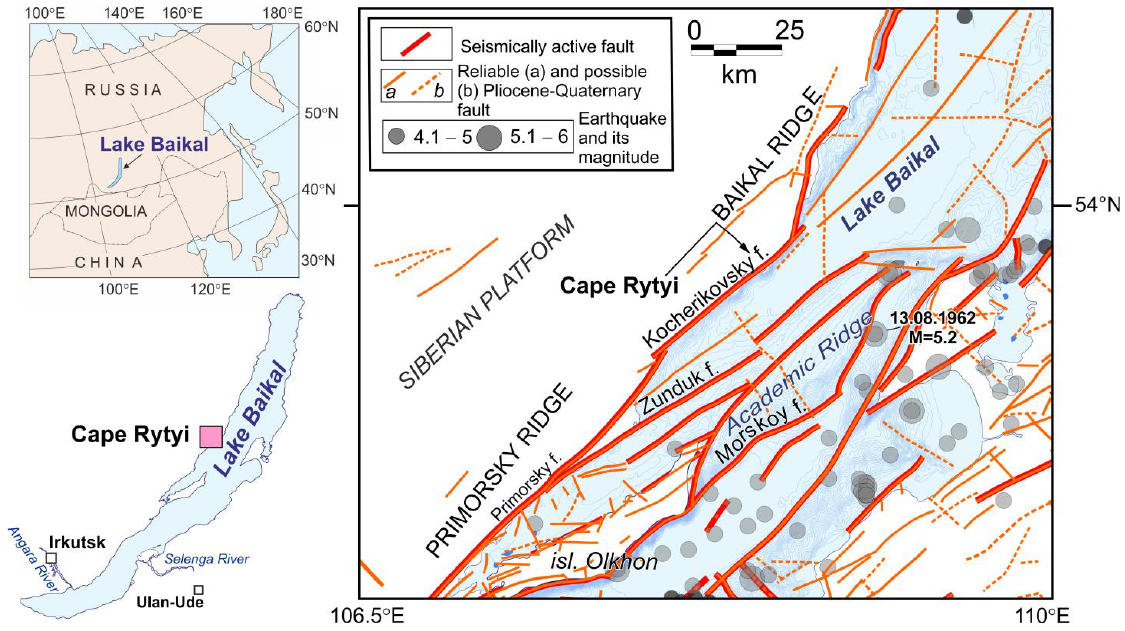
Figure 1. Location map of Cape Rytyi ( left ) and its tectonic framework ( right ). Epicenters of in- strumentally recorded earthquakes with a magnitude М ≥ 4.1 during 1950–2019, according to [10], are shown (labeled date is for the event mentioned in